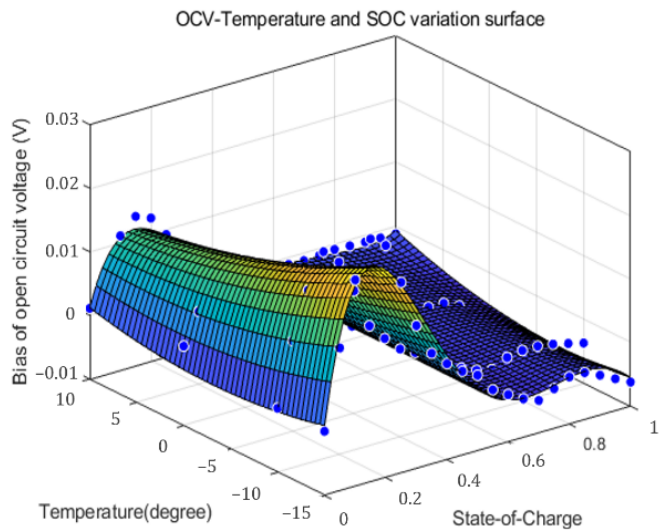
Figure 11. Bias of open circuit voltage (V).